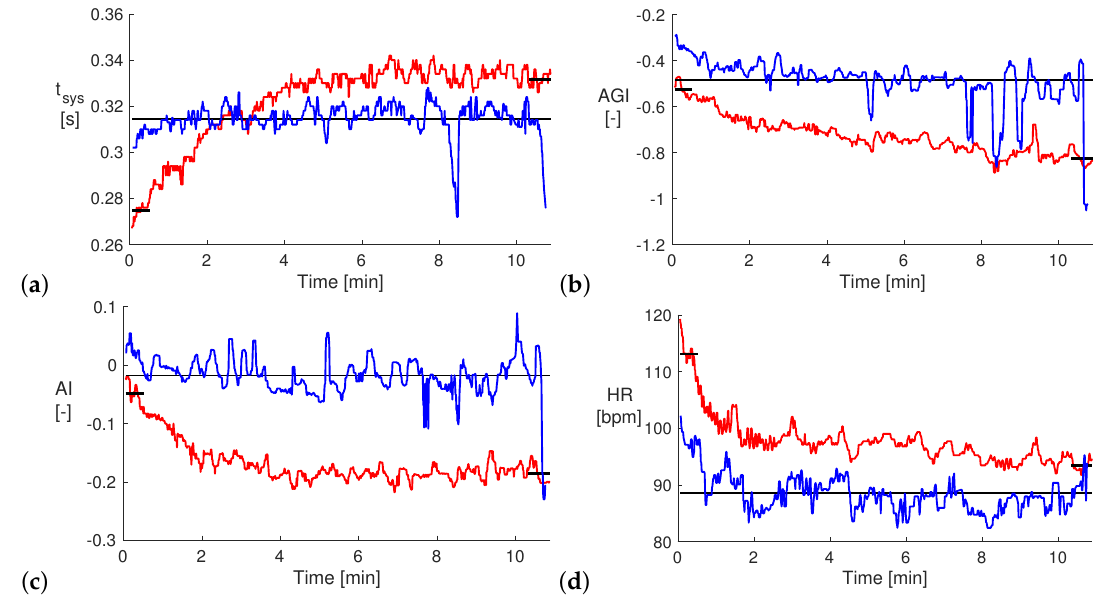
Figure 2. Exemplary Changes in VRR Indices After Exercise: ( a ) duration of systole ( t sys ); ( b ) ageing index (AGI); ( c ) augmentation index (AI); ( d ) heart rate (HR). Red lines indicate the recovery recording, blue lines the rest recording prior to exercise, and black lines show the mean VRR values during the initial and final parts of the recovery recording and the baseline mean during the rest recording. bpm: beats per minute; au: arbitrary